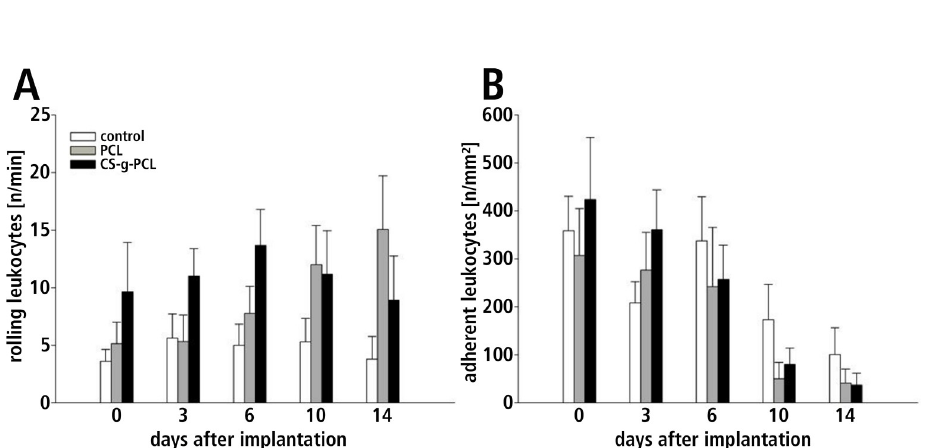
Fig 4. Leukocyte-endothelium interaction. Leukocyte-endothelium interaction at the periphery of the implants in post-capillary and collecting venules after implantation. (A) Number of rolling leukocytes 0, 3, 6, 10 and 14 days after implantation shown as number of cells/min. The implantation of different materials did not significantly increase the number of rolling leukocytes. (B) Number of adherent leukocytes 0, 3, 6, 10 and 14 days after implantation as number of cells/mm 2 . The number of adherent leukocytes at the border zones of the implants decreased over the evaluation period.